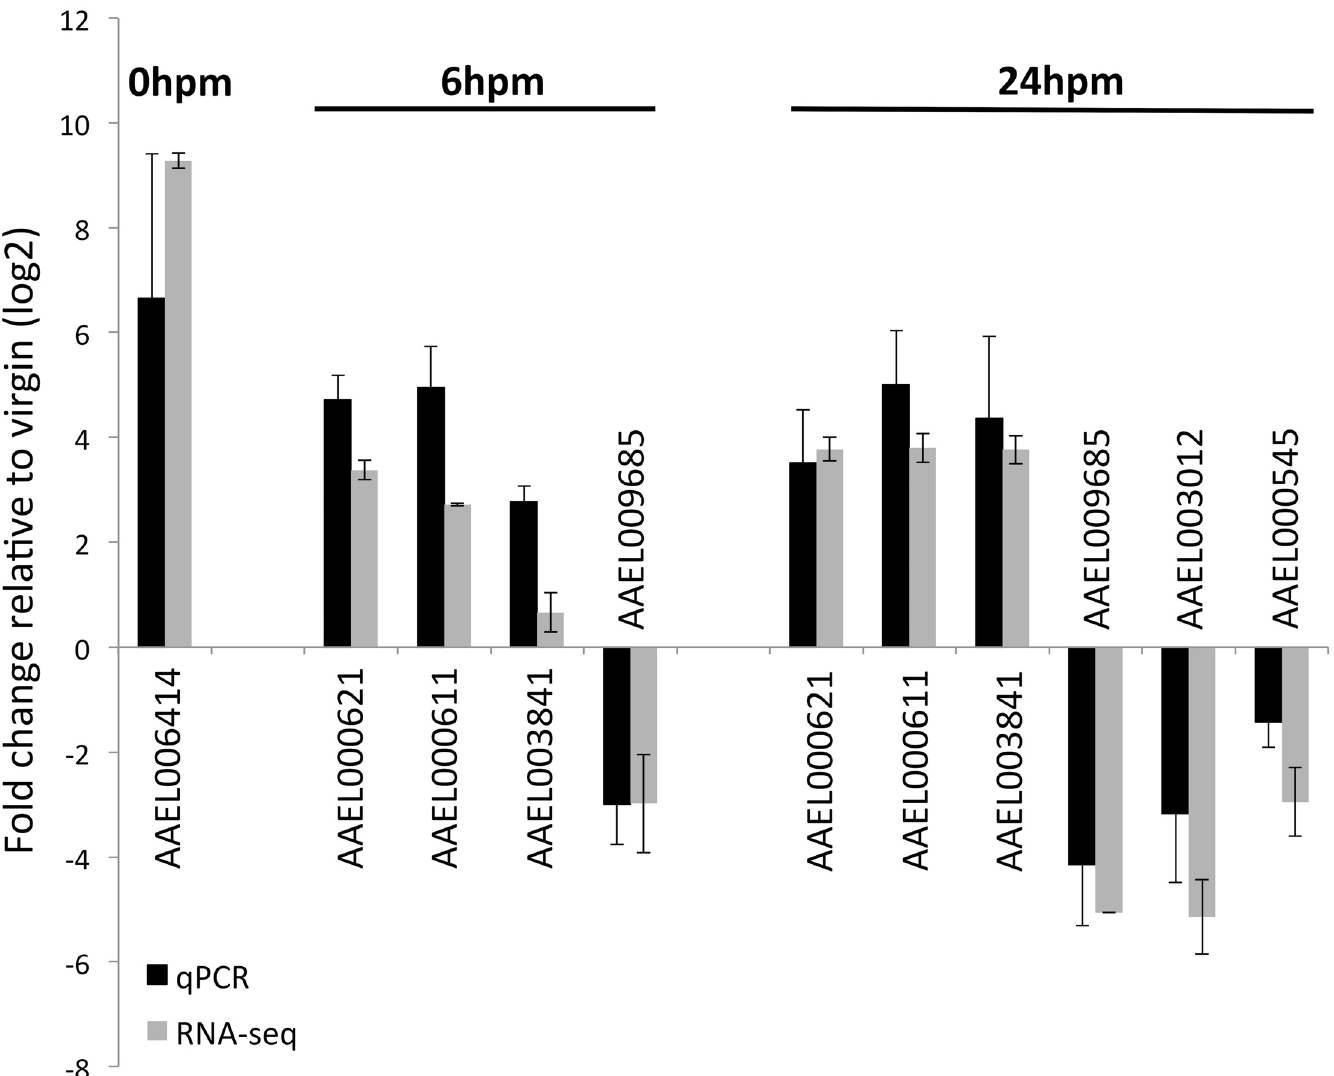
Fig 2. Expression patterns of seven genes using quantitative RT-PCR. Each sample was obtained from the female reproductive tract minus the ovaries at different time points after mating. Each sample represents three different biological replicates, two of them using the expression of the gene RpS17 for normalization and a third using actin expression. Black bars show the results of the quantitative PCR and gray bars show the results of the RNAseq data. Error bars represent standard deviation. A Pearson correlation coefficient shows a positive correlation between qRT-PCR and RNAseq results ( R 2 = 0.912, p -value =